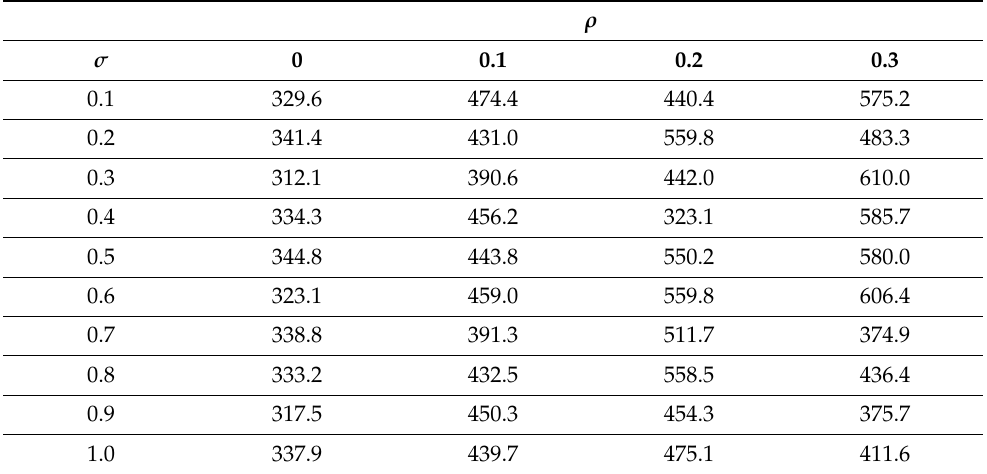
Table 4. Average run length by ρ and σ for the Farlie-Gumbel-Morgenstern